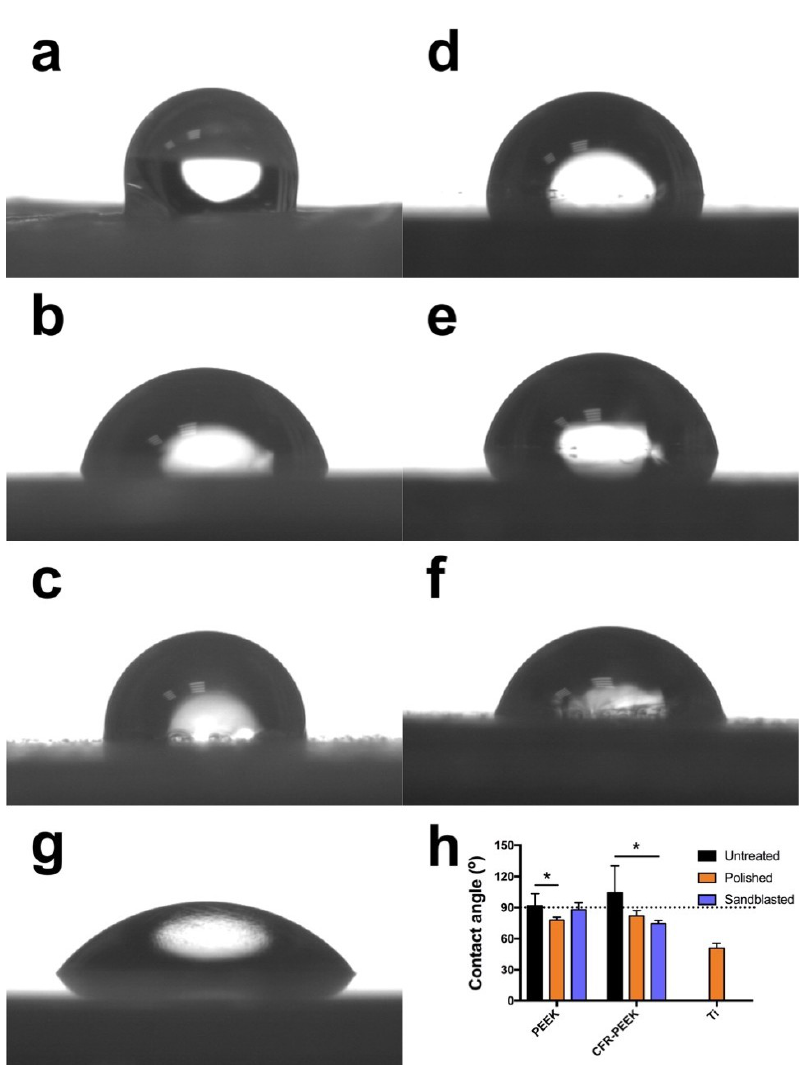
Figure 5. Water contact angle measured on untreated, polished, and sandblasted PEEK and CFR‐PEEK samples: ( a ) untreated PEEK; ( b ) polished PEEK; ( c ) sandblasted PEEK; ( d ) untreated CFR‐PEEK; ( e ) polished CFR‐PEEK; ( f ) sandblasted CFR‐PEEK. ( g ) Ti (additional reference); ( h ) quantitative contact angle values (means ± standard deviation). The dotted line indicates the contact angle of 90°, which is the division of hydrophilicity and hydrophobicity, * p < 0.05.